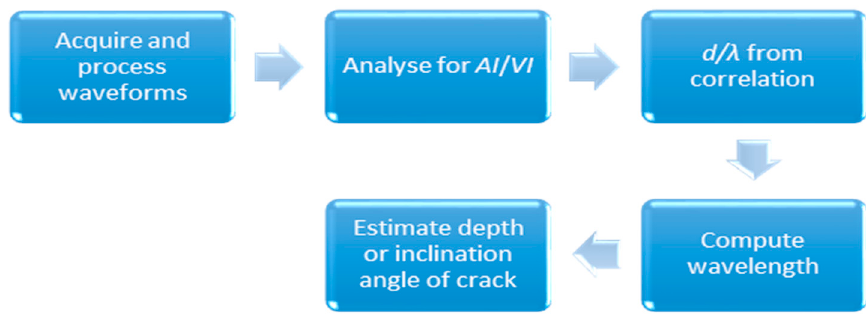
Figure 12. Procedure for crack depth and degree of inclination estimation.